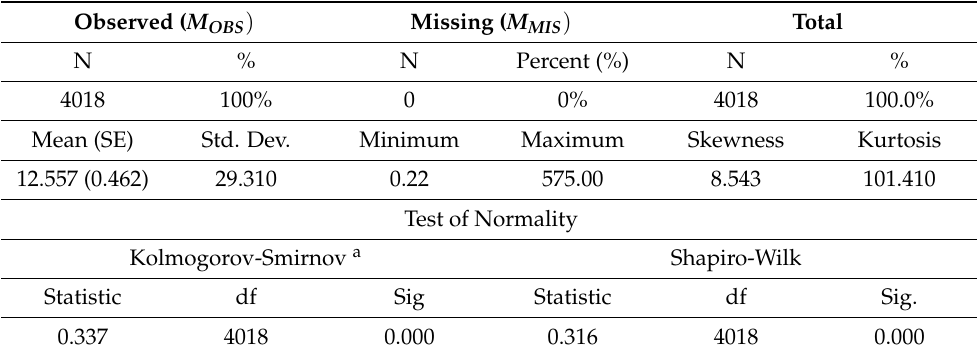
Table 4. Descriptive statistics and Normality test results of the complete Maduwang catchment data. Observed ( M OBS )